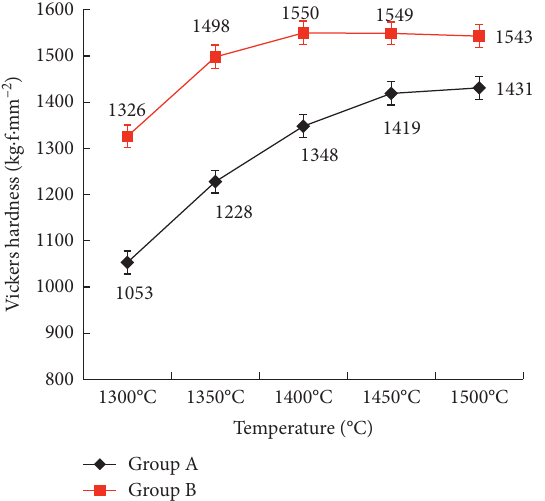
Figure 14: Vickers hardness of samples at different microwave sintering temperatures.